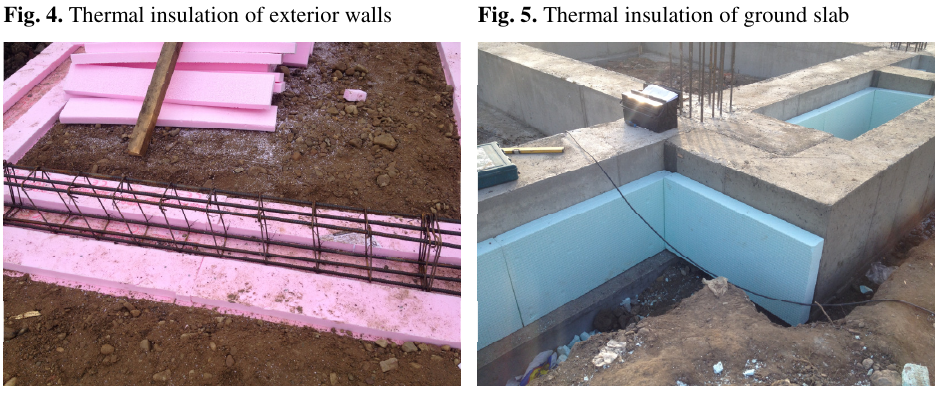
Fig. 6. Thermal bridge free design of beams Fig. 7. Thermal bridge free design of foundations